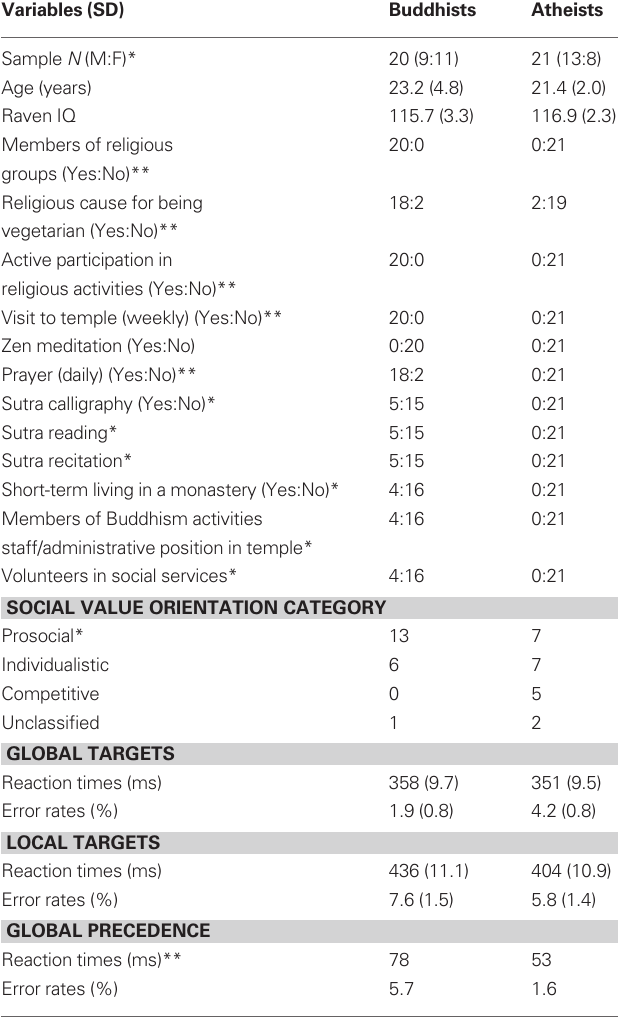
Table 1 | Demographic characteristics and religious behavior of participants, and performance on globally and locally defined